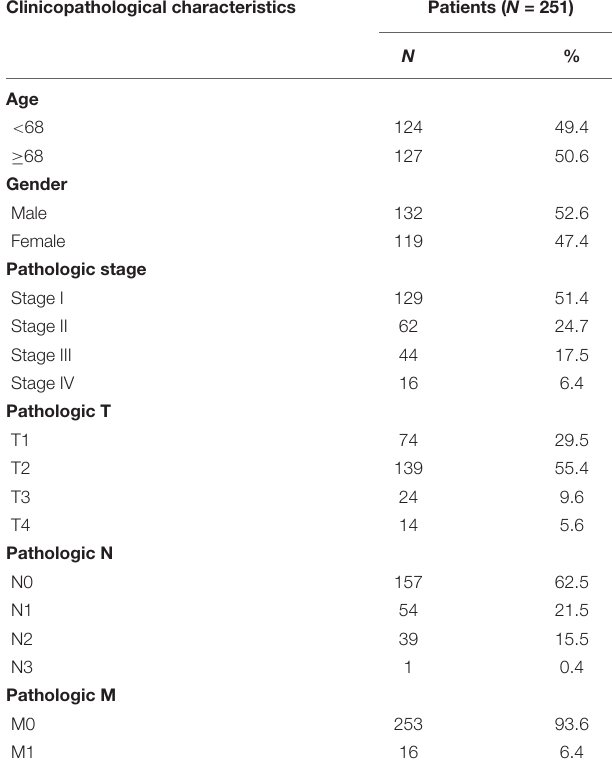
TABLE 1 | Clinicopathological characteristics of 251 LUAD